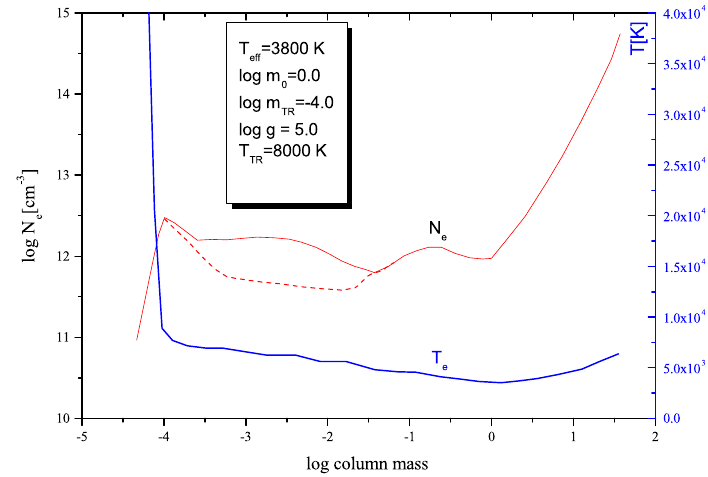
Figure 12. Structure of model atmosphere–electron density Ne and temperature Te as a function of column